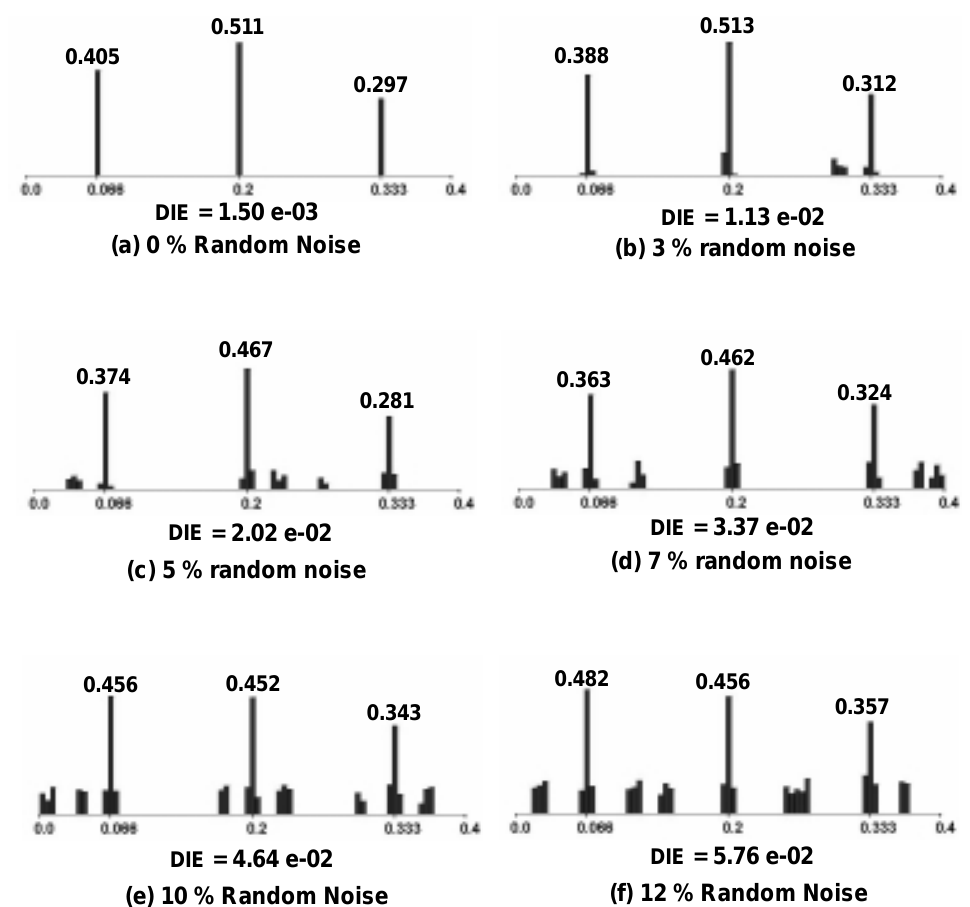
Fig. 5. The effects of the noise in measured FRF-data on the damage identification results obtained by the reduced-domain